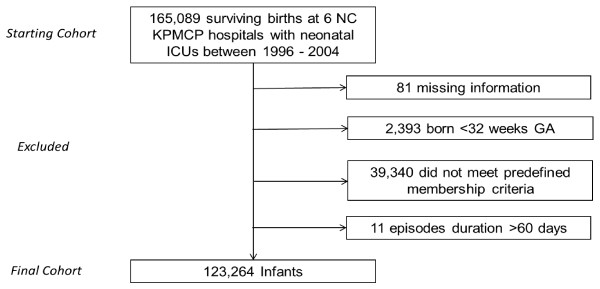
Cohort Selection Process.